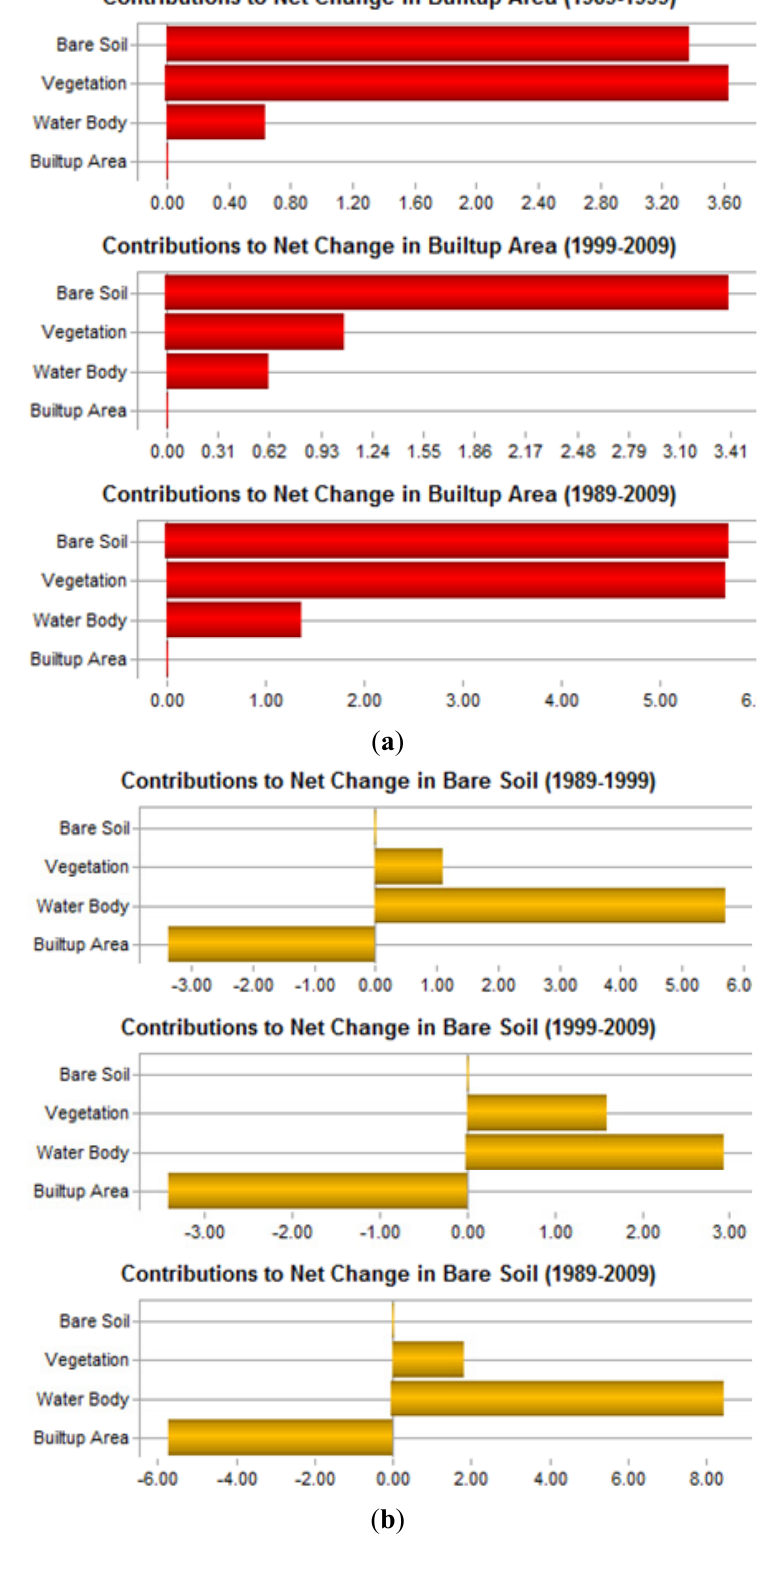
Figure 8. Contributions to net change ( a ) in built-up area and ( b ) in bare soil of DMP area (Unit: % of